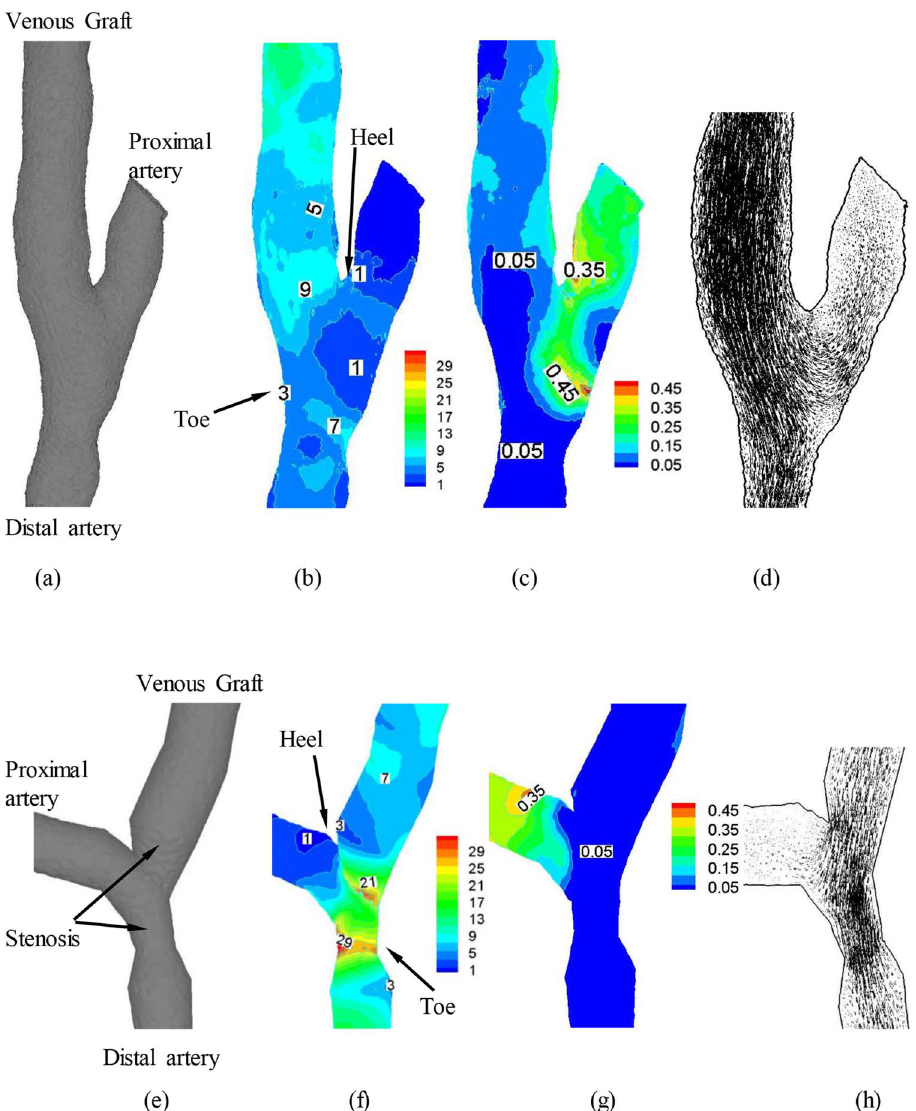
Figure 3. The anastomosis between SVG and coronary artery obtained from patient CTA with: (a) small anastomotic stenosis (area stenosis , 20%) and the distribution of (b) time-averaged (over a cardiac cycle) WSS (Unit: Dynes ? cm 2 2 ), (c) OSI and (d) time- averaged flow velocity (Unit: cm/s); (e) mild anastomotic stenosis (40% , area stenosis , 60%) and the distribution of (f) time- averaged WSS (Unit: Dynes ? cm 2 2 ), (g) OSI and (h) time-averaged flow velocity (Unit: